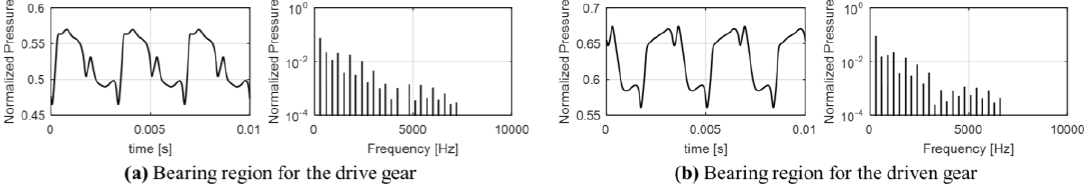
Figure 12. Pressure ripples at the bearing region for the ( a ) drive gear and ( b ) driven gear depending on time (left) and frequency (right).